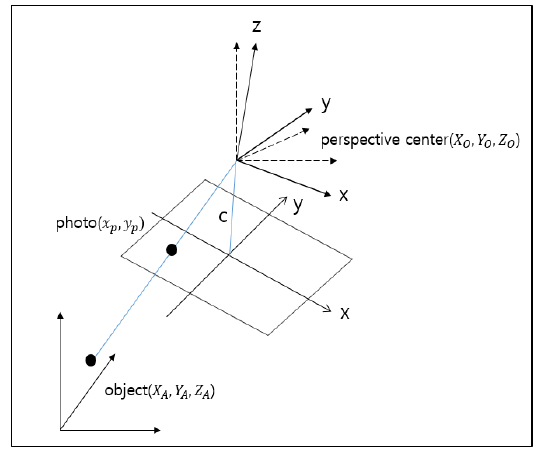
Figure 1 Collinearity Condition The collinearity condition equation for the ground point j of the image I is equal to follow